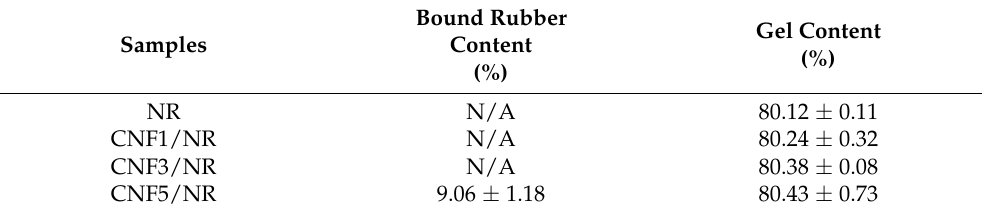
Table 5. Bound rubber contents and gel contents of the NR and the CNF/NR